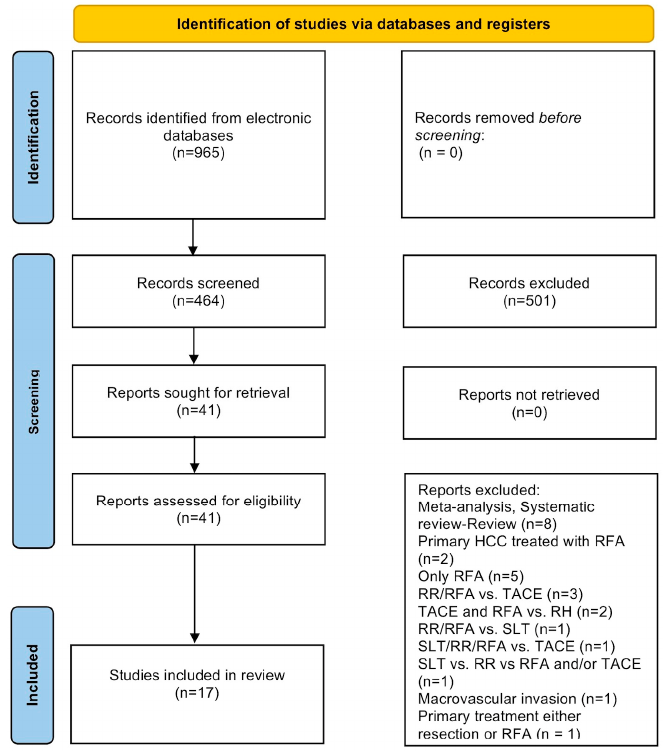
Figure 1. Search flow diagram.